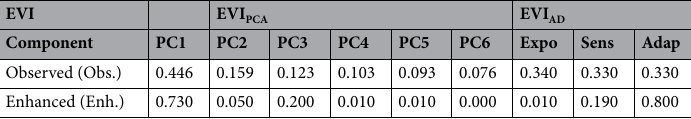
Table 7. Observed and enhanced rate for